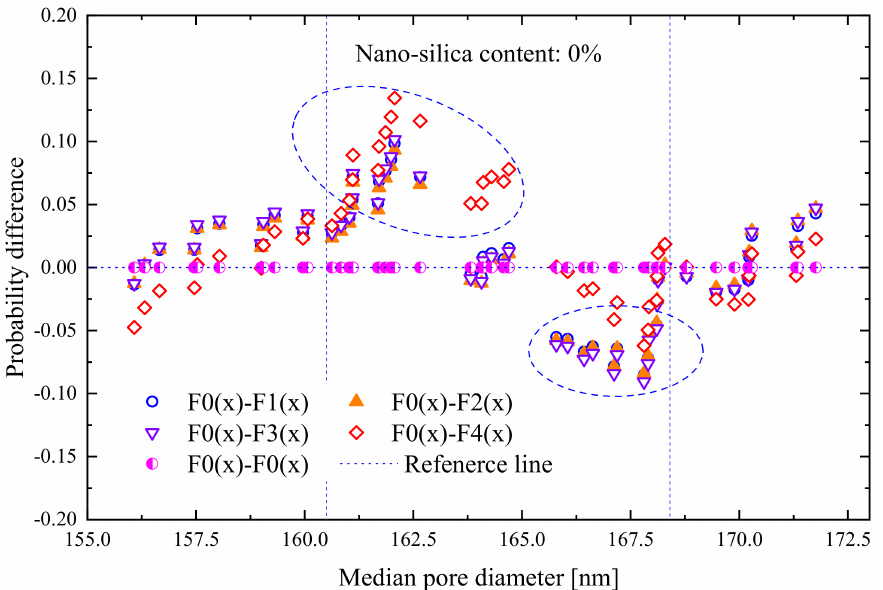
Figure 8. The probability difference between distributions and experimental median pore diame- ters ( F i ( x ) , i = 0, 1, 2, 3, and 4 represent the measured, normal, lognormal, Gamma, and Weibull distributions,